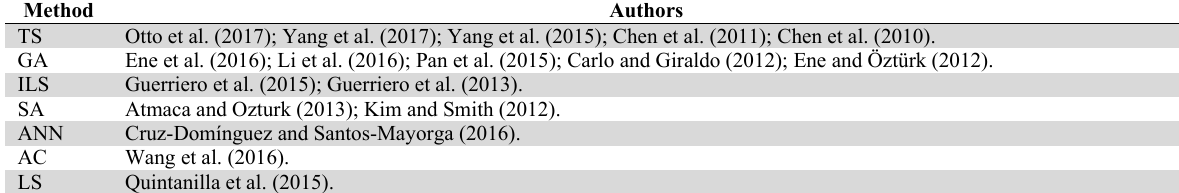
Relationship between metaheuristic methods and authors